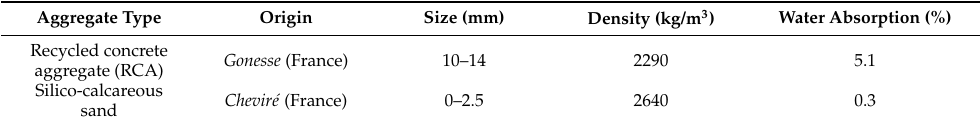
Table 1. Physical properties of sand and coarse aggregates.